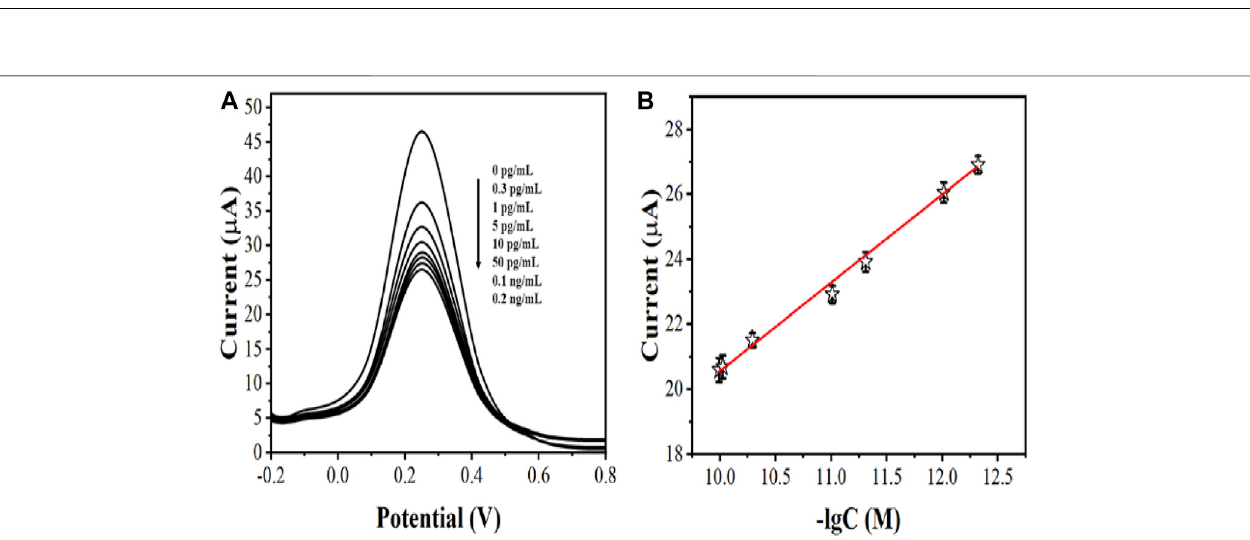
FIGURE 7 | (A) DPV curves of AcTnI/AgNPs/MoS 2 /rGO/GCE toward 0 pg/ml, 0.3 pg/ml, 1 pg/ml, 5 pg/ml, 10 pg/ml, 50 pg/ml, 0.1 ng/ml, and 0.2 ng/ml (B) Linear relationship between current and logarithm of the cTnl concentrations ( n ≥ 3).